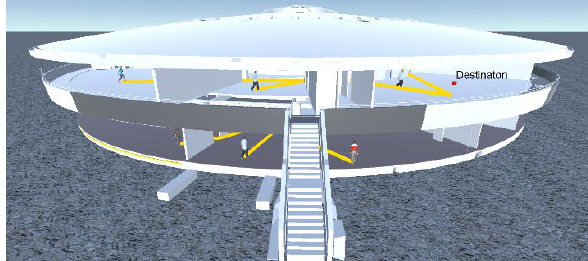
Figure 2: Indoor wayfinding to a specific destination, Round House, UNSW,